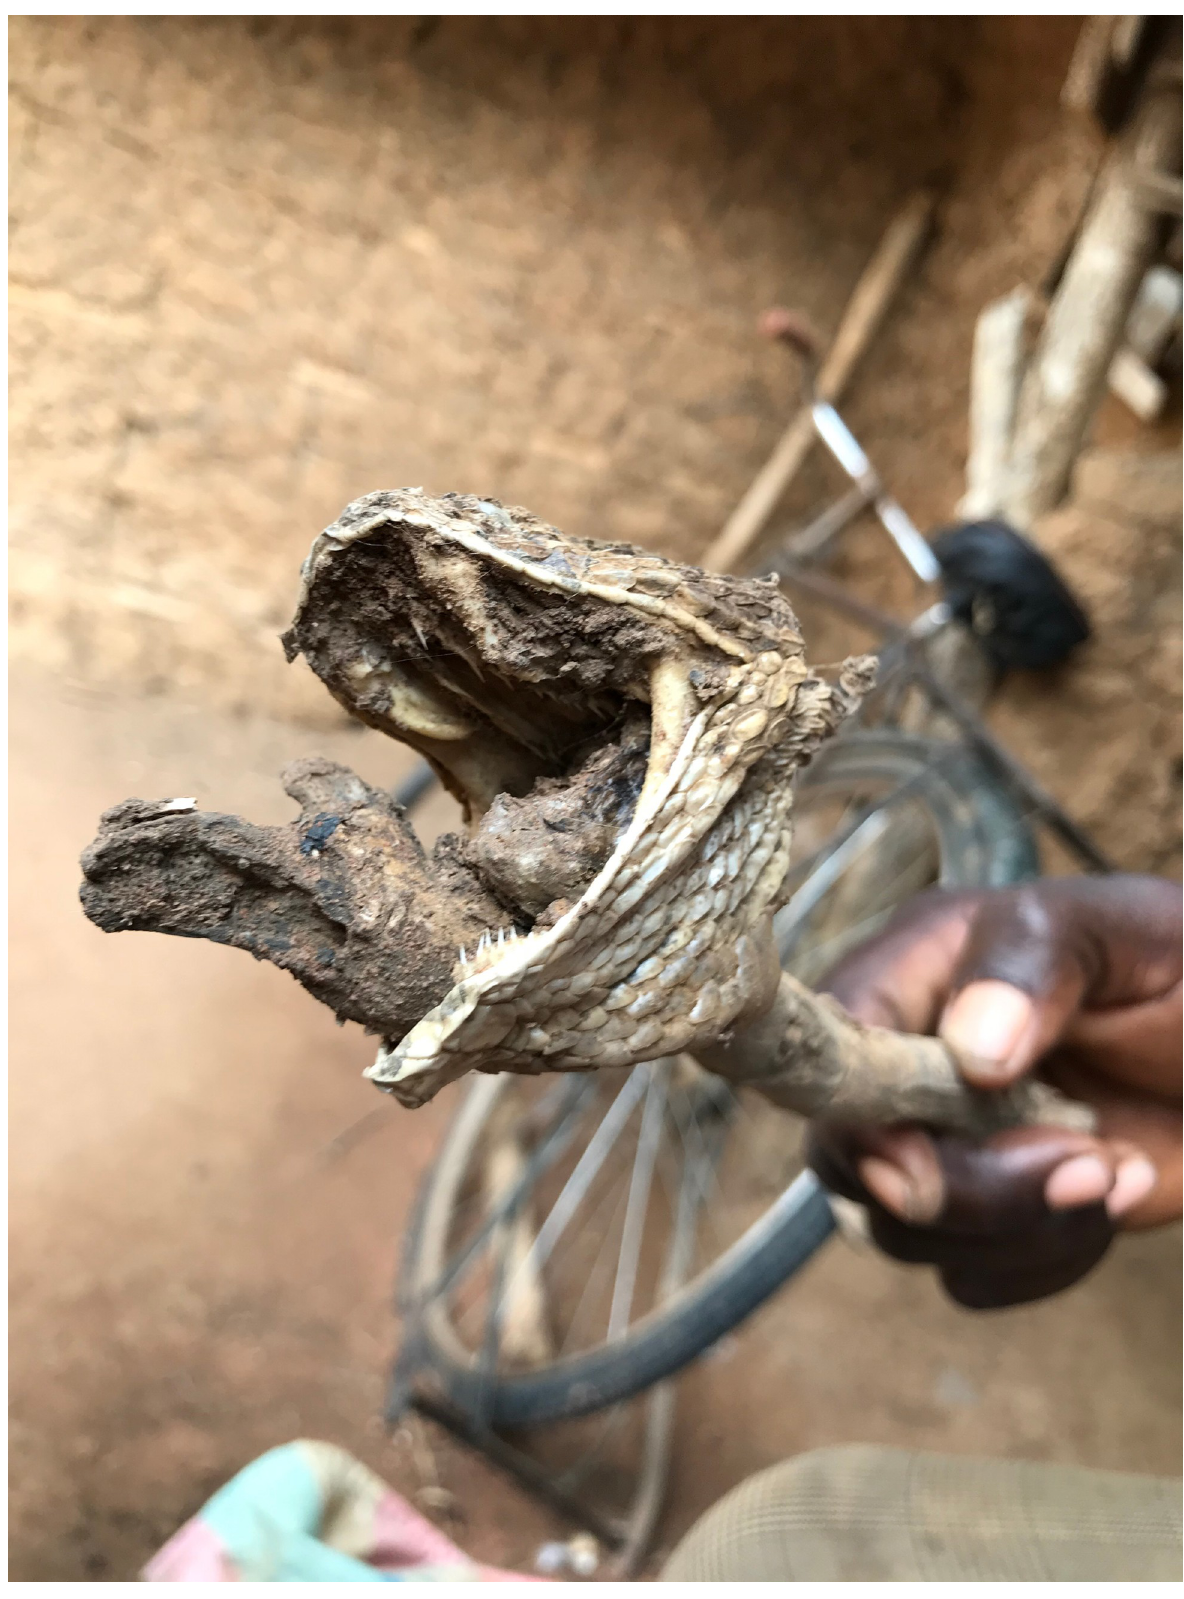
Fig 4. Head of a dead puff adder used as treatment ingredient by a traditional healer. https://doi.org/10.1371/journal.pntd.0009298.g004 PLOS NeglectedTropical Diseases | https://doi.org/10.1371/journal.pntd.0009298 April 16,